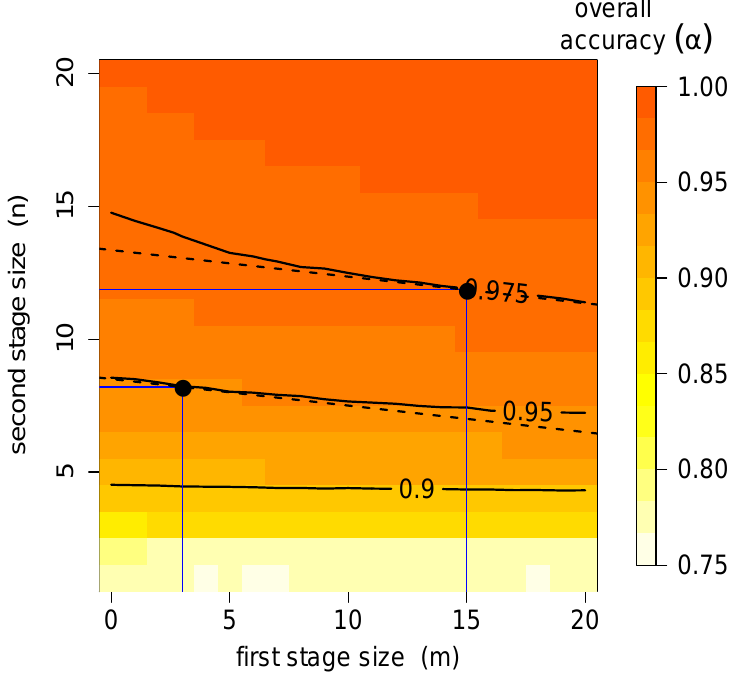
Figure 7. The overall classification accuracy α for BF2 as a function of m and n , the first stage and second stage sizes. The solid lines are the iso-accuracy lines, corresponding to combinations of m and n , resulting in the same accuracy. The dashed lines are the iso-cost lines for the K = 5 class case study based on the Geo-Wiki data. The tangent points correspond to optimal resource